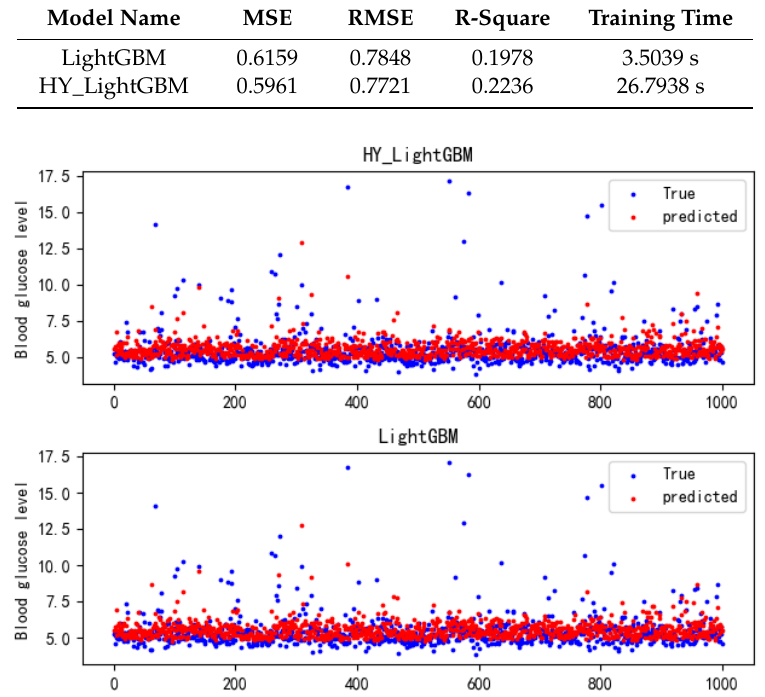
Table 4. Prediction performance comparison between the HY_LightGBM model and LightGBM model.